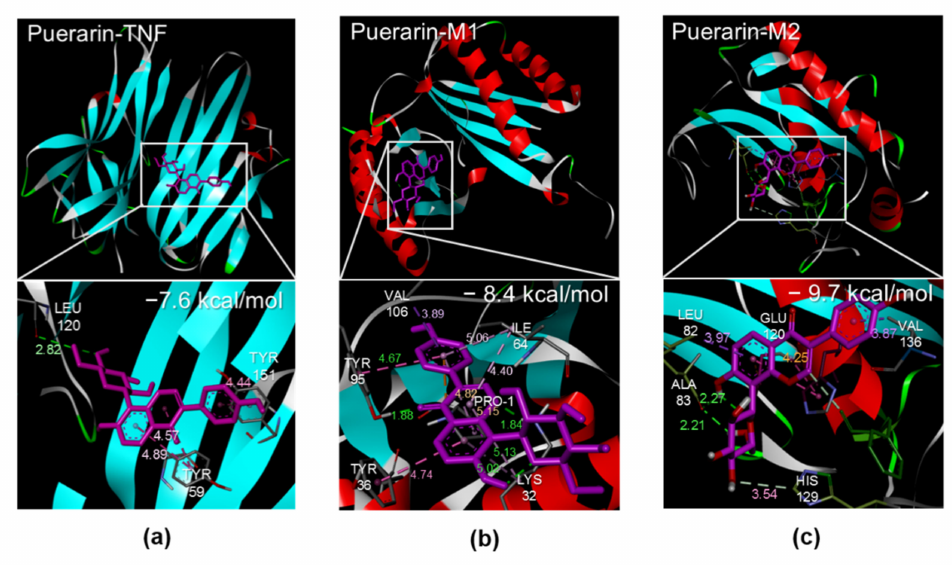
Figure 2. Molecular docking. ( a ) Puerarin and TNF. ( b ) Puerarin and M1 macrophage. ( c ) Puerarin and M2 macrophage. TNF (PDB ID: 2AZ5), M1 macrophage (PDB ID: 1GD0), and M2 macrophage (PDB ID: 1JIZ). The binding energy is written at the top